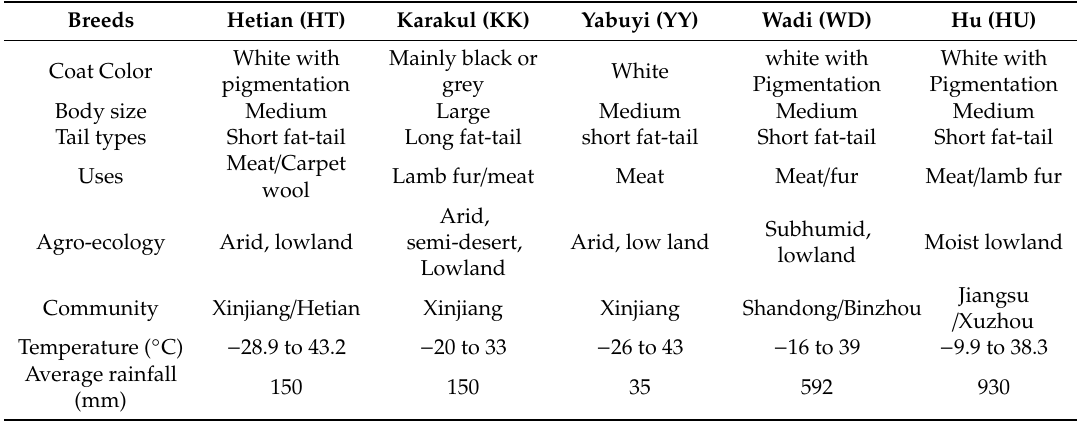
Table 1. Description of five native Chinese fat-tailed sheep breeds and their agro-ecological locations. Breeds Hetian (HT) Karakul (KK) Yabuyi (YY) Wadi (WD) Hu (HU) White with Mainly black or white with White with Coat Color White pigmentation Pigmentation Pigmentation grey Body size Medium Large Medium Medium Medium Tail types Short fat-tail Long fat-tail short fat-tail Short fat-tail Short fat-tail Meat / Carpet Lamb fur / meat Meat Meat / fur Meat / lamb fur Uses wool Arid, Subhumid, Moist lowland Agro-ecology Arid, lowland semi-desert, Arid, low land lowland Lowland Community Xinjiang / Hetian Xinjiang